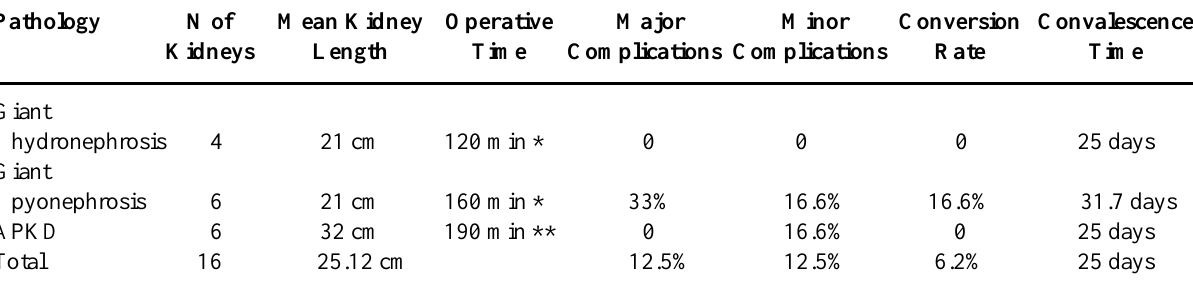
* operative times corresponding to unilateral nephrectomy; ** operative times corresponding to bilateral nephrectomies; APKD = adult polycystic kidney